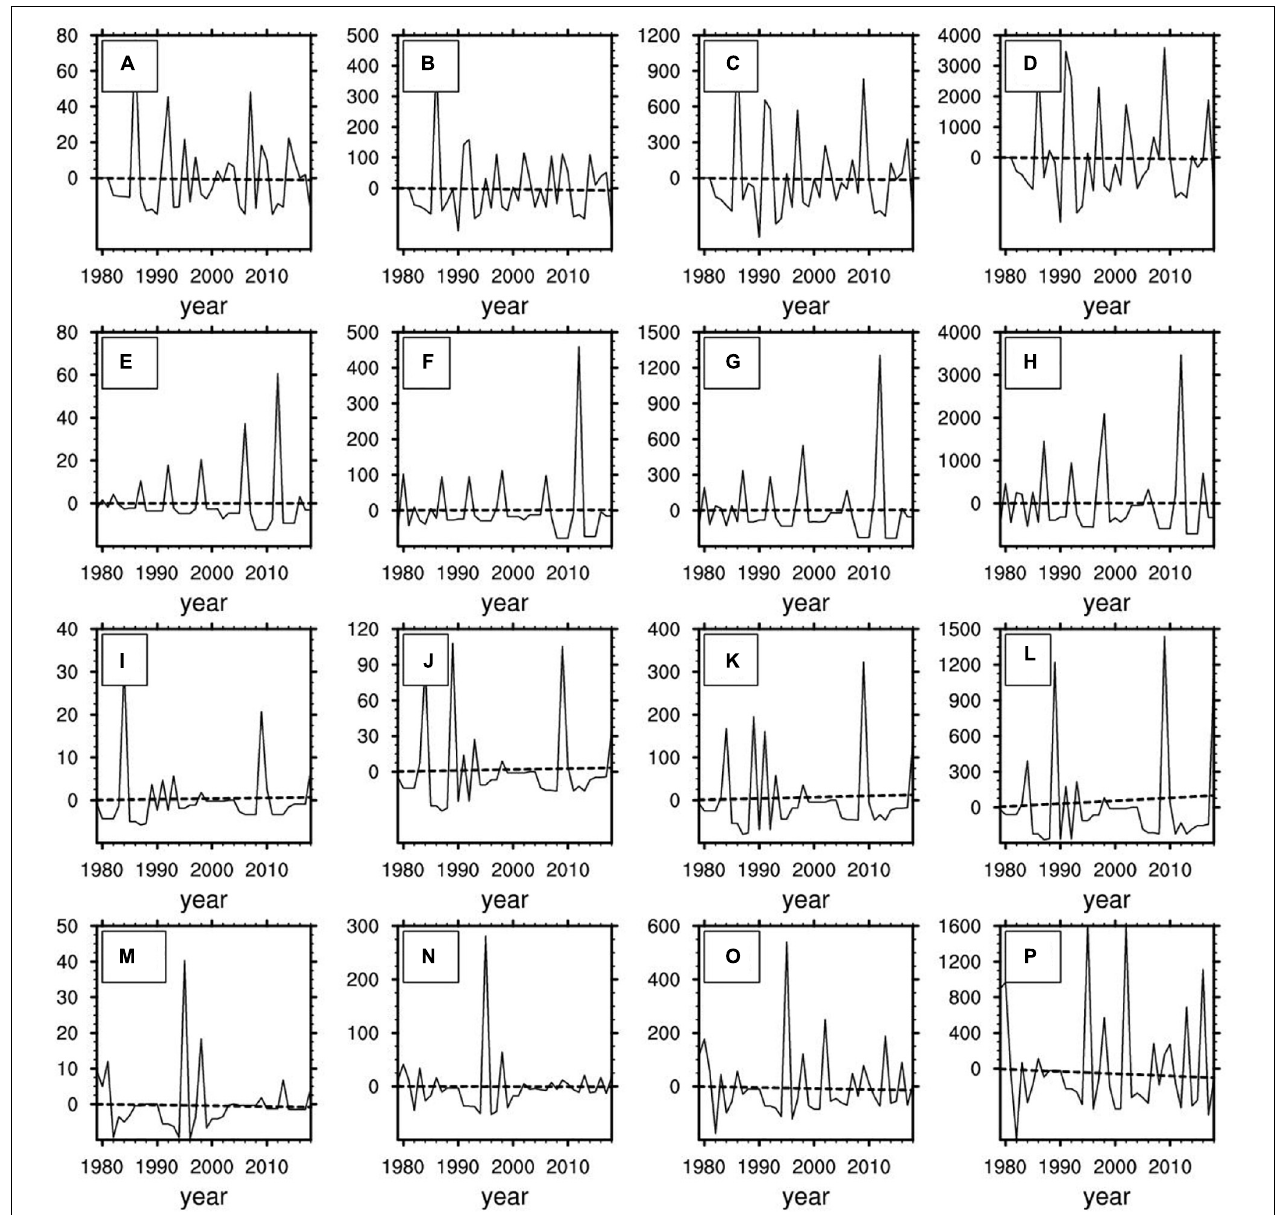
FIGURE 6 | Interannual variation sequences of the precipitation anomalies at various magnitude levels for these four types of NCCV events ranging from 1979 to 2018 (unit: mm): (A,E,I,M) Rainstorms; (B,F,J,M) Heavy rain; (C,G,K,O) Moderate rain; (D,H,L,P) Light